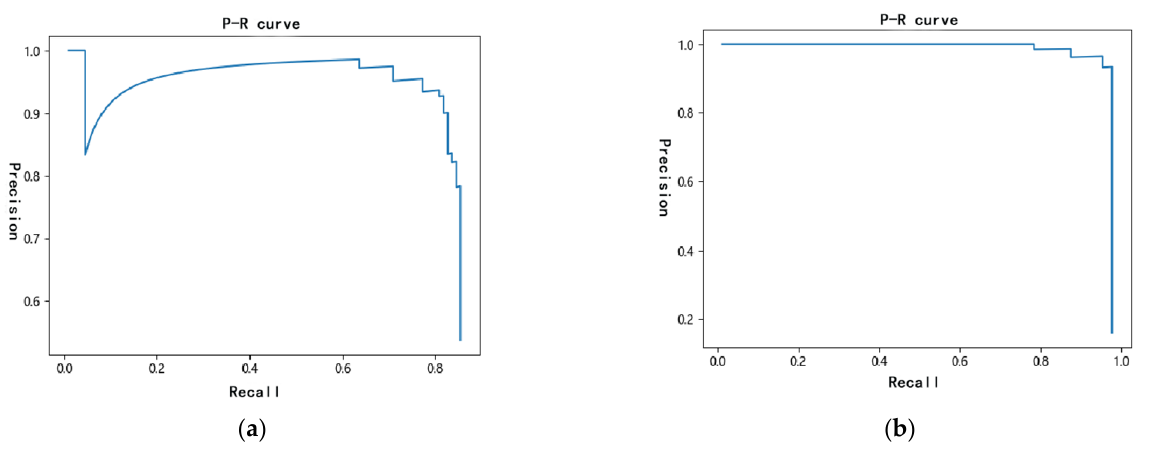
Figure 14. P-R curve. ( a ) YOLOv4; ( b ) MobileNetv2-YOLOv4.